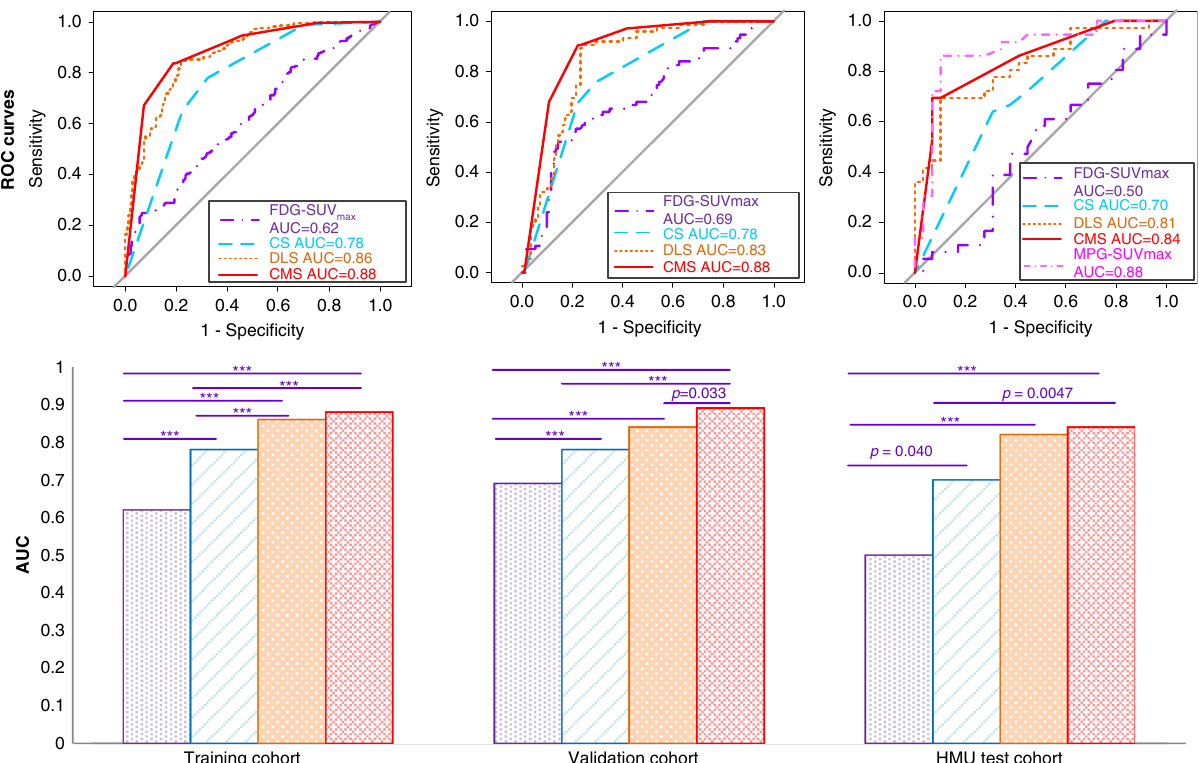
Fig. 2 Performance of the EGFR-DLS in predicting EGFR status across different cohorts. The top row are the ROC curves of different models in the training, validation, and HMU test cohorts, respectively. The bottom row are the AUC values and the comparison results with Delong test. For statistical comparisons among different models, a two-sided Delong test was used. *** denotes a p value <0.001. If p value is otherwise, it is noted. Statistics for AUC, sensitivity, speci fi city, and accuracy for all cohorts are provided in Supplementary Table